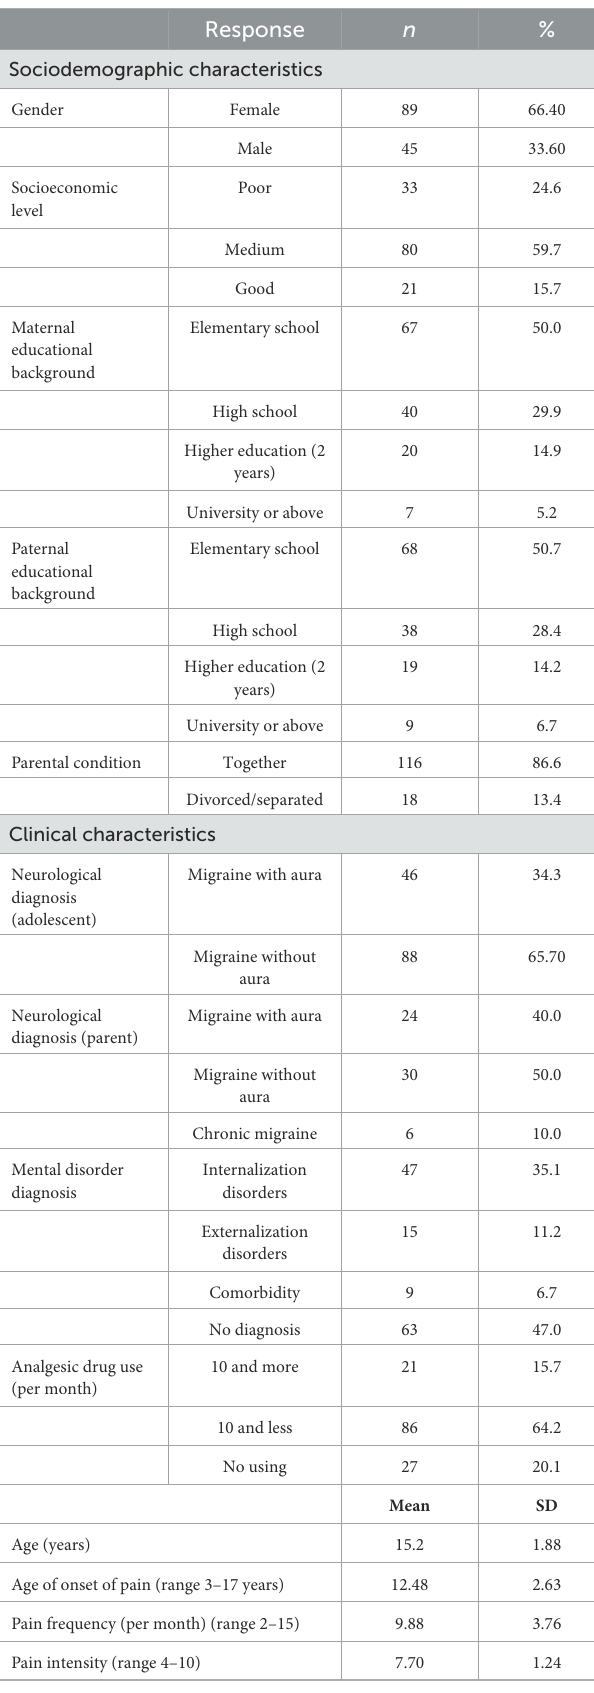
TABLE 1 Descriptive statistics for sociodemographic and clinical characteristics of the sample ( N =